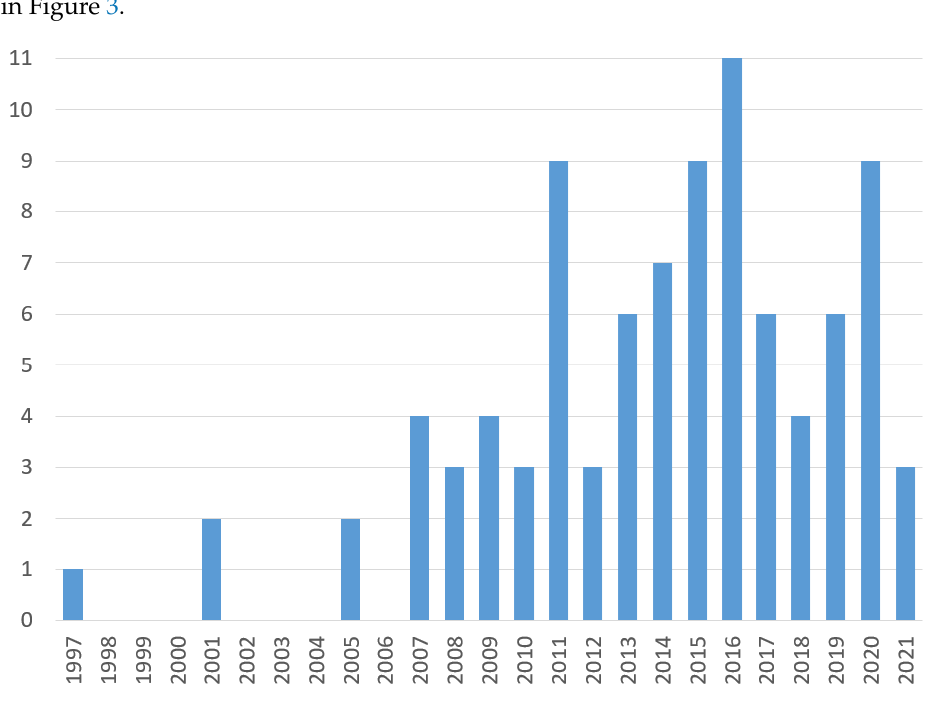
Figure 2. Distribution of publications by